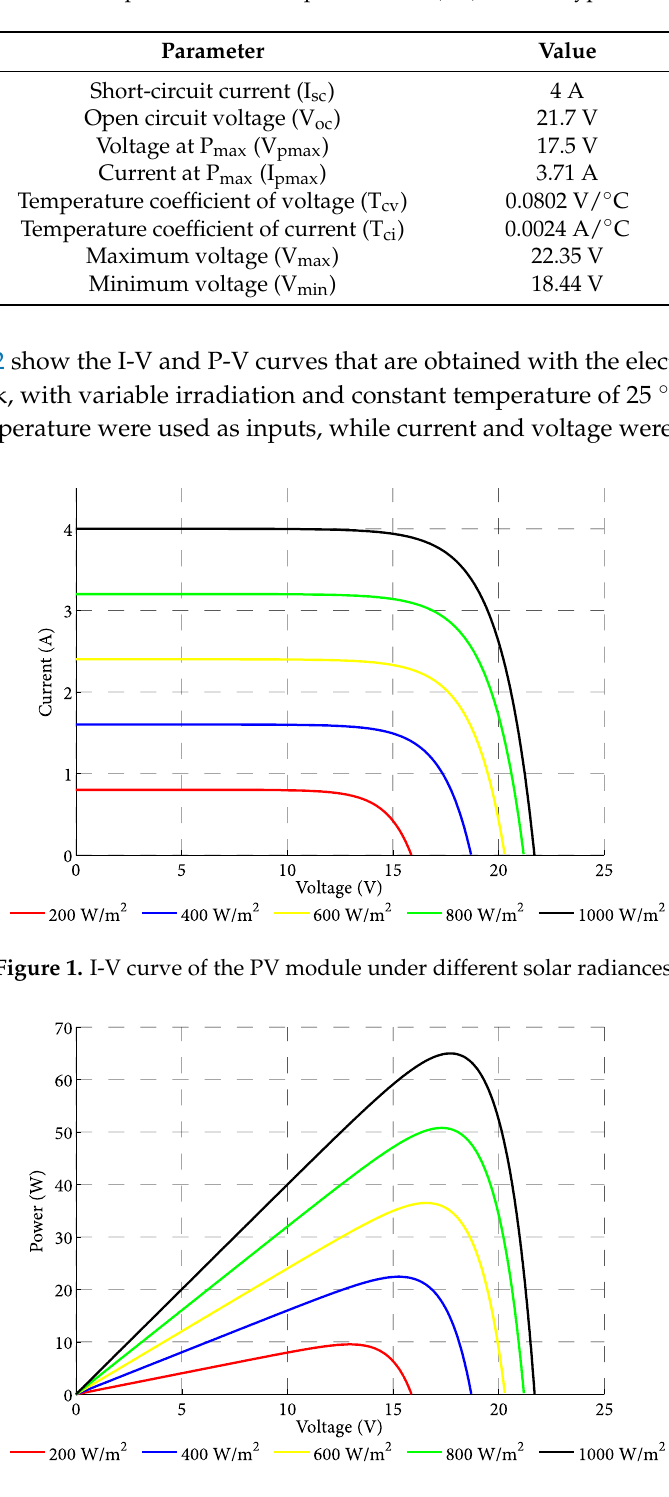
Figure 2. P-V curve of the PV module under different solar radiances.